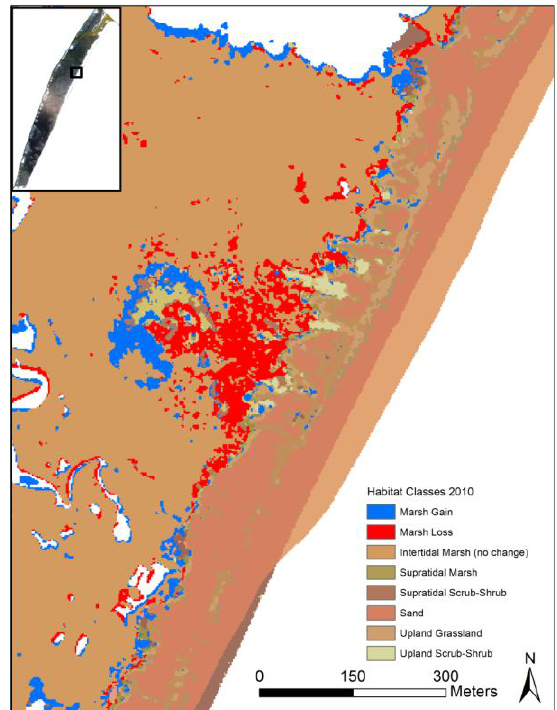
Figure 10. Change in intertidal marsh from 2002 to 2010 at an example back barrier location. Gains in marsh (blue) and losses in marsh (red) tend to occur in close proximity.